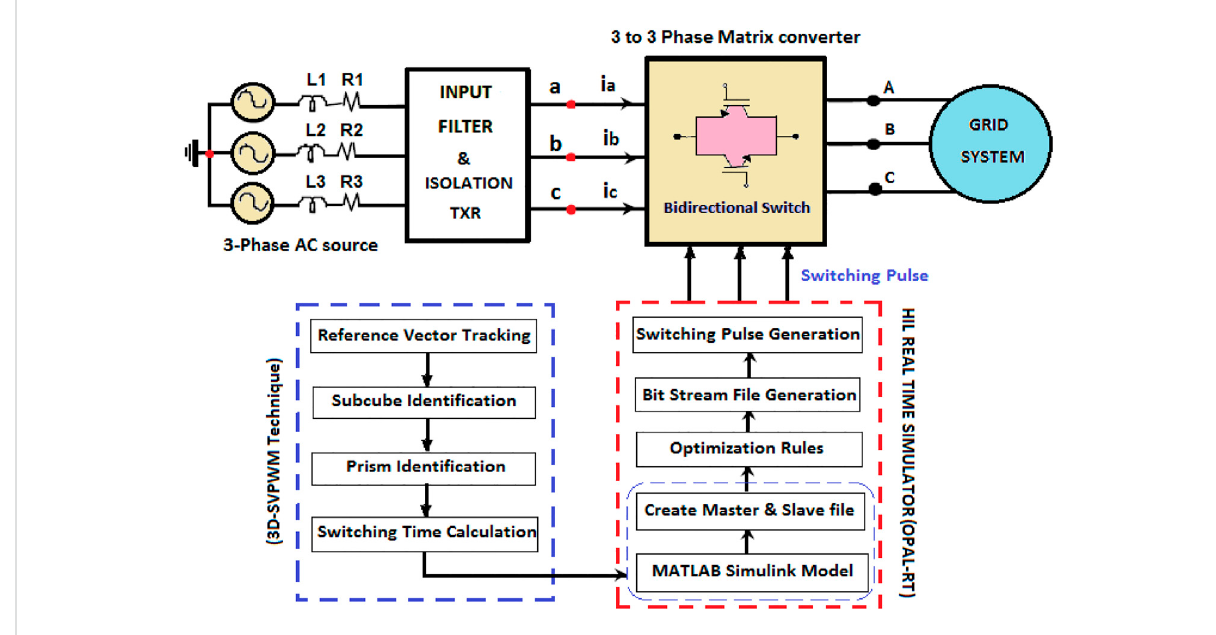
FIGURE 1 Control strategies for proposed 3D-SVPWM for MC.